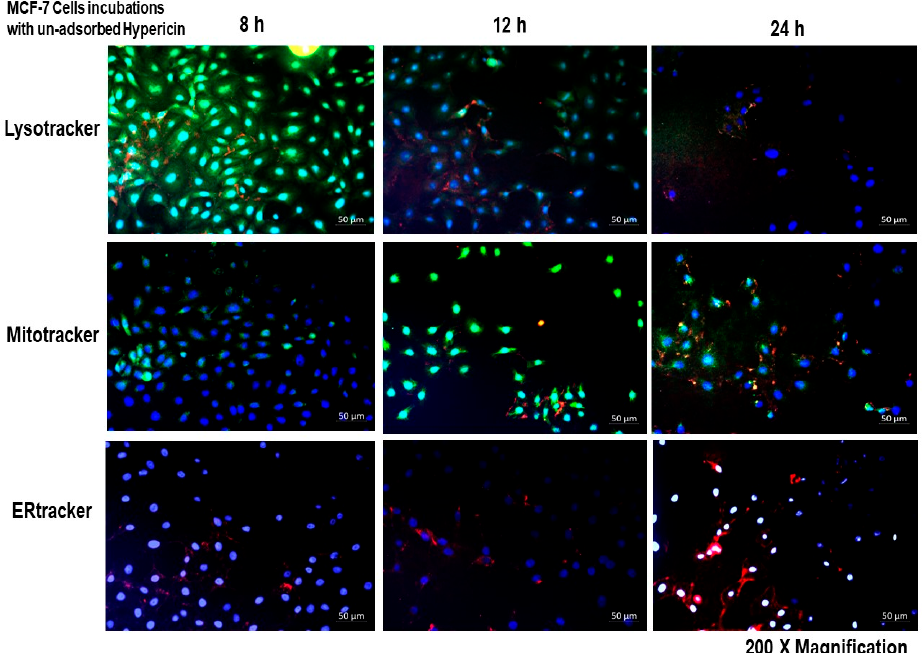
Figure 5. Hypericin localization in MCF-7 cells. A significant amount of hypericin accumulates in the lysosomes and the mitochondrion at 12 and 24 h, indicated by the orange color, mixture of green from the lysotracker and mitotracker and red from hypericin. No hypericin localization on the endoplasmic reticulum (ER tracker) was observed at any incubation time. Cell nuclei were counterstained with DAPI (blue).